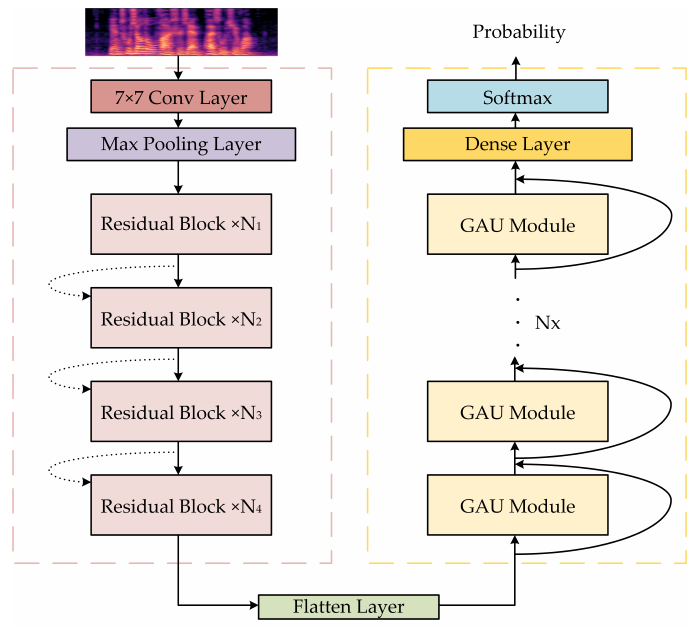
Figure 7. Overall framework of the